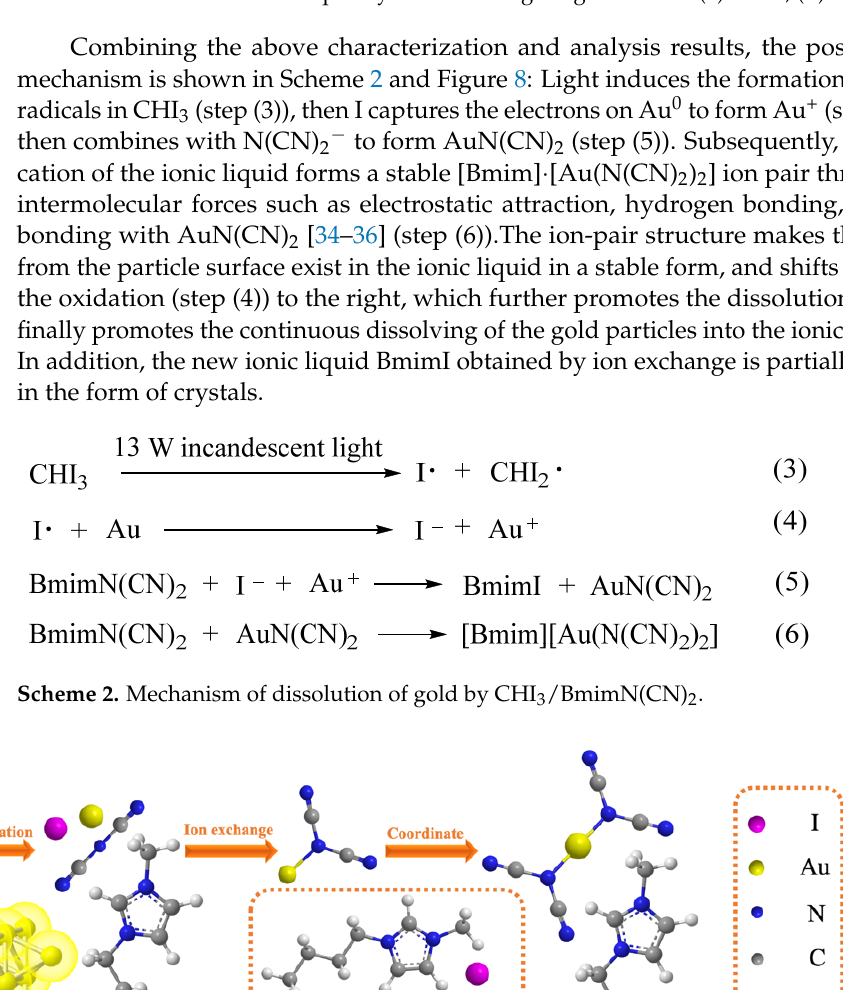
Figure 7. XPS spectrum of Au 0 dissolved in ionic liquid system under lighting condition: ( a ) Au 4f, ( b ) I 3d.